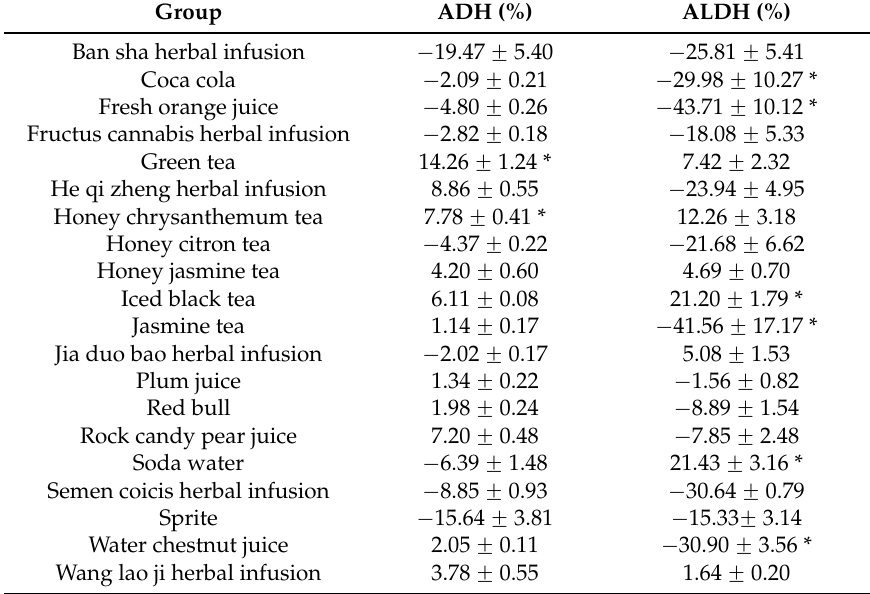
Table 2. Effects of the 20 selected beverages on ADH and ALDH activity in liver. Group ADH (%) ALDH (%) Ban sha herbal